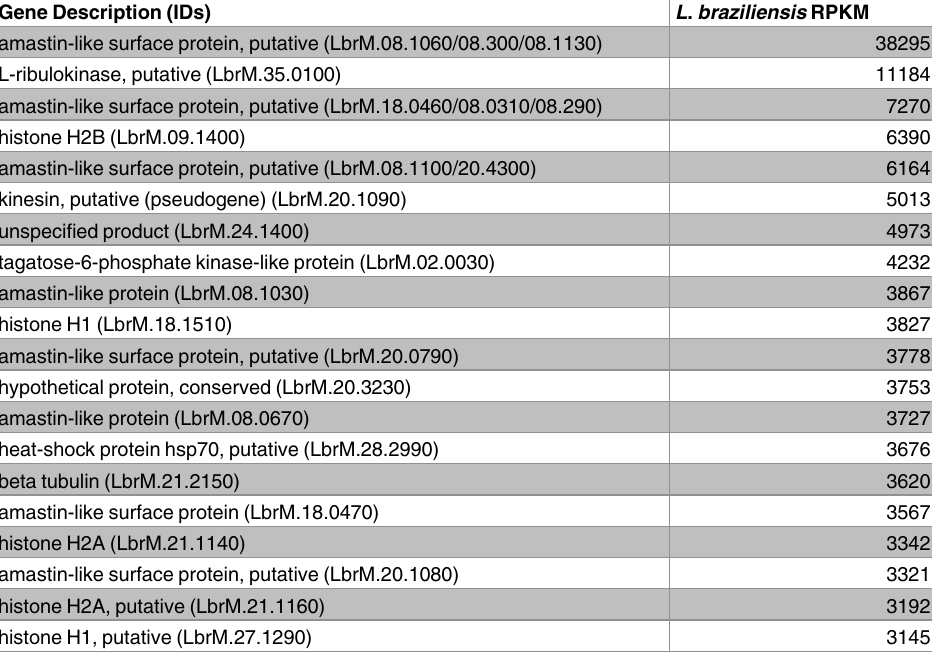
Table 1. Top 20 L . braziliensis genes expressedin detectable-positive lesions as ranked by RPKM. Gene Description